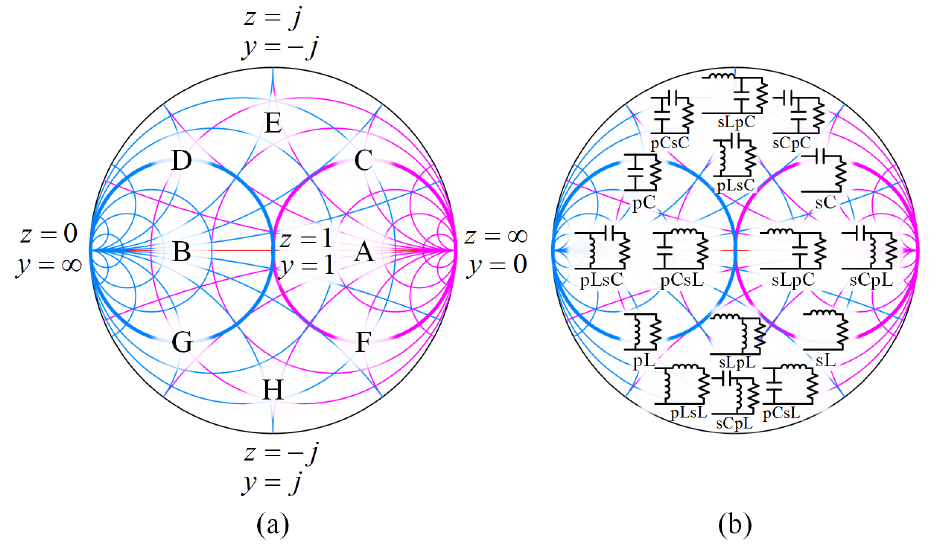
Figure 4. Normalized smith chart for matching network design: ( a ) Load regions; ( b ) Matching network